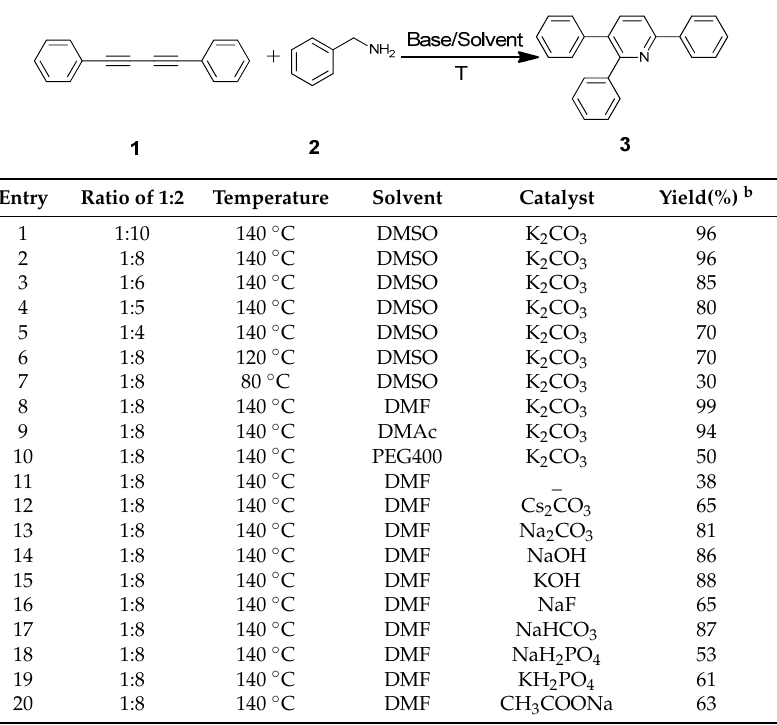
Table 1. Optimization of the reaction conditions a .